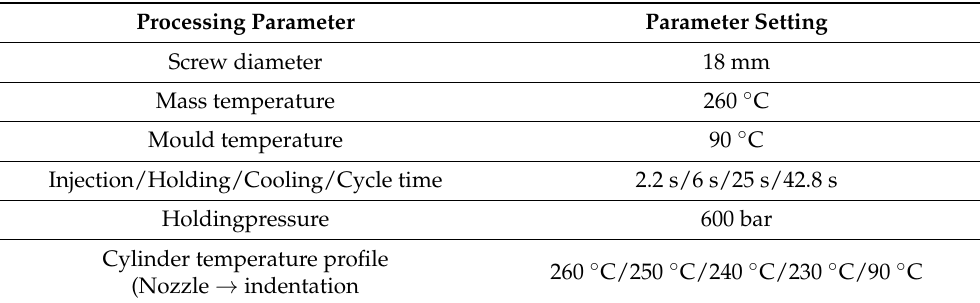
Table 2. Main processing parameters for the manufacturing of the plastic gears.